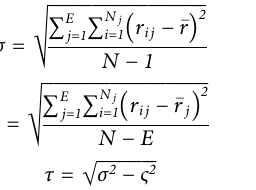
algorithm (Kingma and Ba, 2014) with a learning rate 0.1 and default